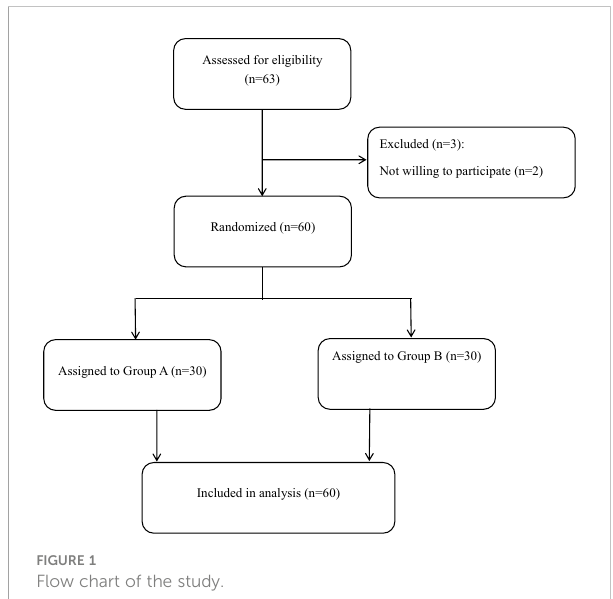
FIGURE 1 Flow chart of the